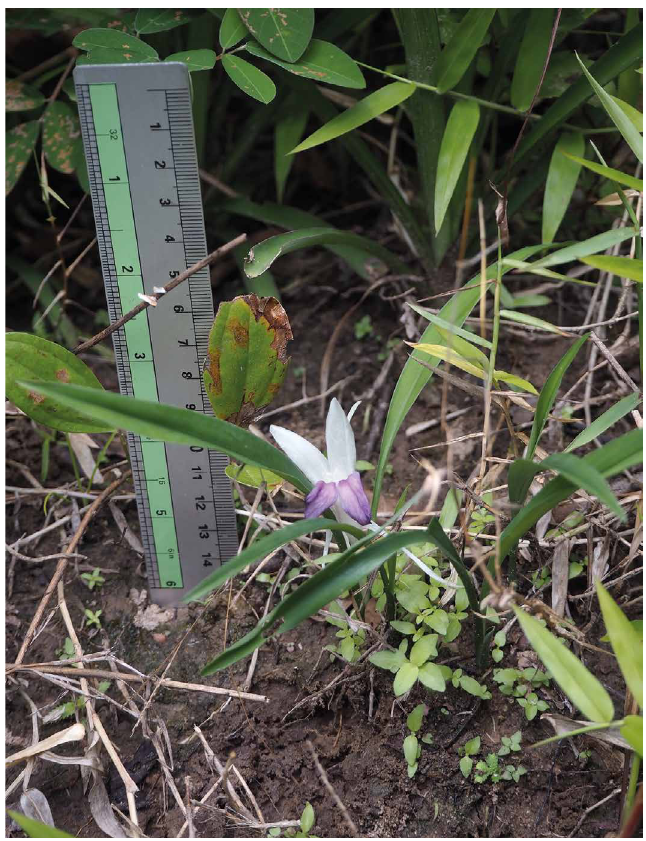
Fig. 1. Kaempferia nemoralis Insis. sp. nov. in natural habitat. Photograph: Oudomphone